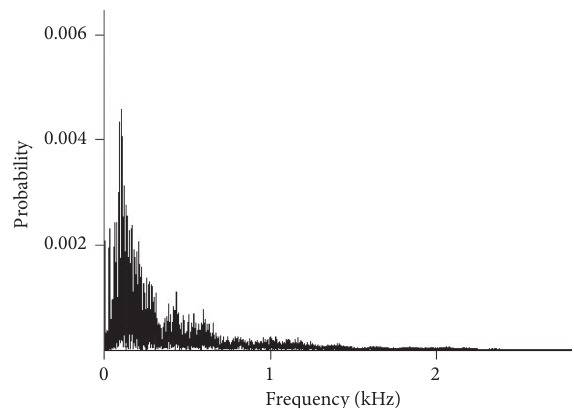
Figure 8: Discrete probability density plots of the Leo